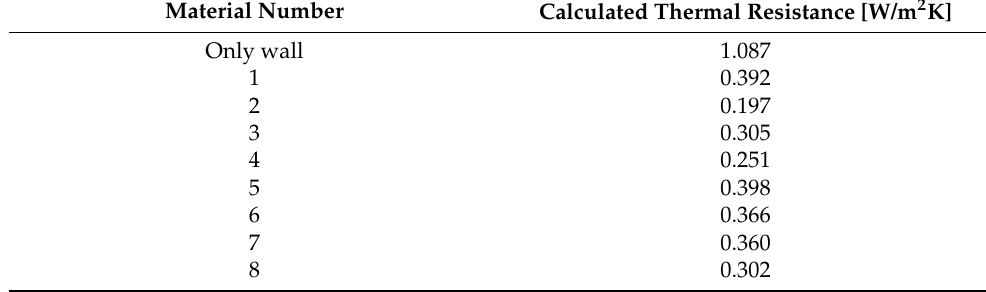
Figure A9. Wall type 3.3: stratigraphy with thicknesses and conductivities for the different layers. The numbers start from the outside. Table A5. Wall type 3.3: thermal transmittance reached with different heat-reflective materials.